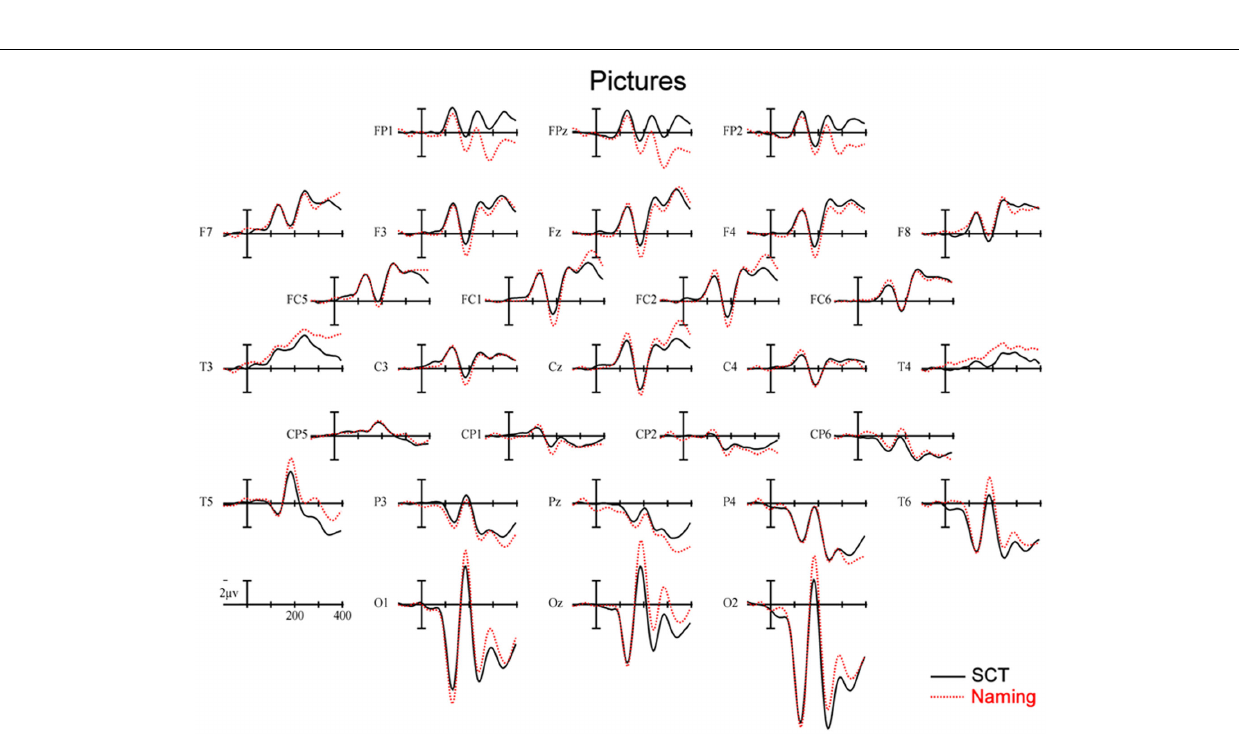
FIGURE 4 | Event-related potentials s recorded to pictures of objects, solid lines are ERPs during a semantic categorization task (SCT) and dashed lines are ERPs recorded in a picture naming task.